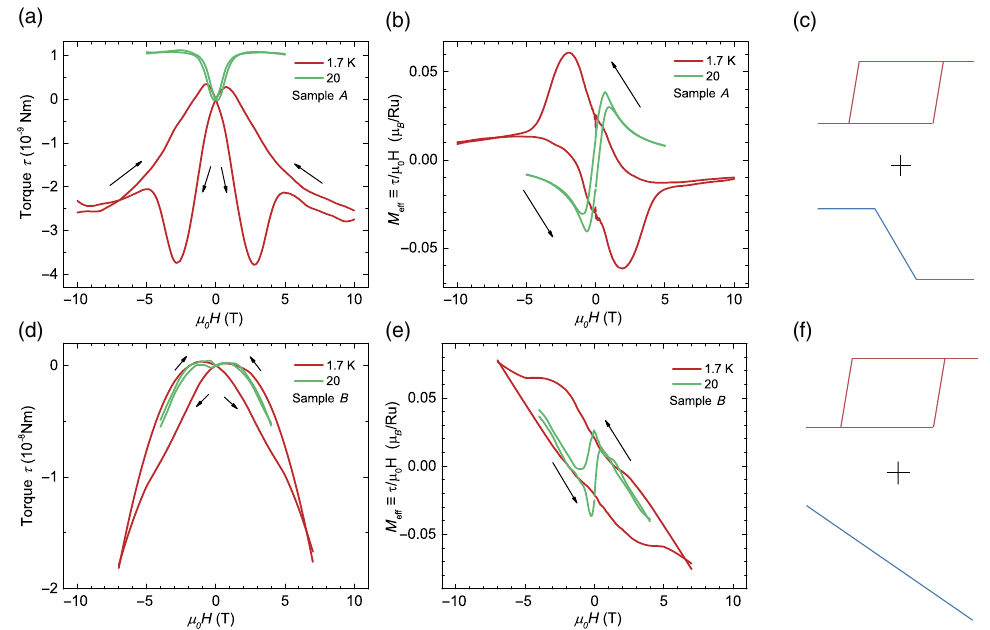
FIG. 13. Torque magnetometry. (a) Torque measured as a function of the applied field at different temperatures for sample A . The magnetic field is applied 70° away from the surface normal. (b) The corresponding magnetization (field) characteristics. Here, the projected magnetization τ =H is shown; to obtain the actual magnetization values, the data should be divided by sin(20°) or by sin(70°) for the in-plane and out-of-plane contributions, respectively. (c) The sketch shows the two contributions to the magnetic signal: the in- plane hysteresis loop (red) and the out-of-plane linear contribution that saturates at high fields (blue). (d) – (f) The same for sample B